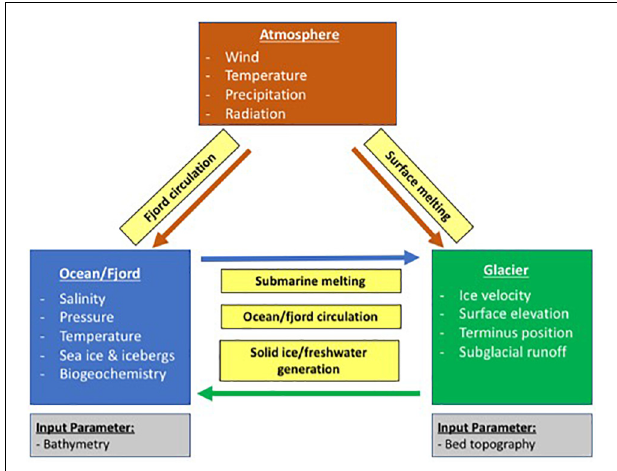
FIGURE 3 | Identified essential variables and their interconnection (inside boxes) at a GrIOOS